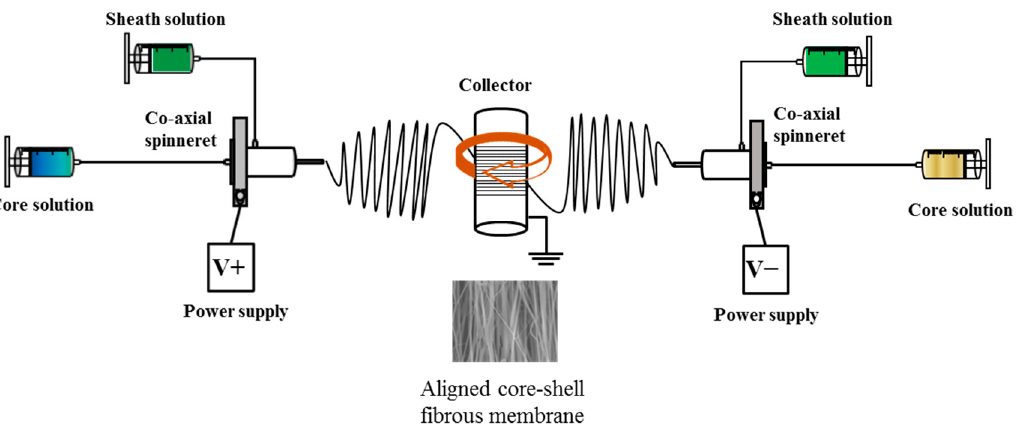
Figure 1. The schematic diagram showing the setup for preparing aligned core–shell fibrous mem- branes (CSFM) by